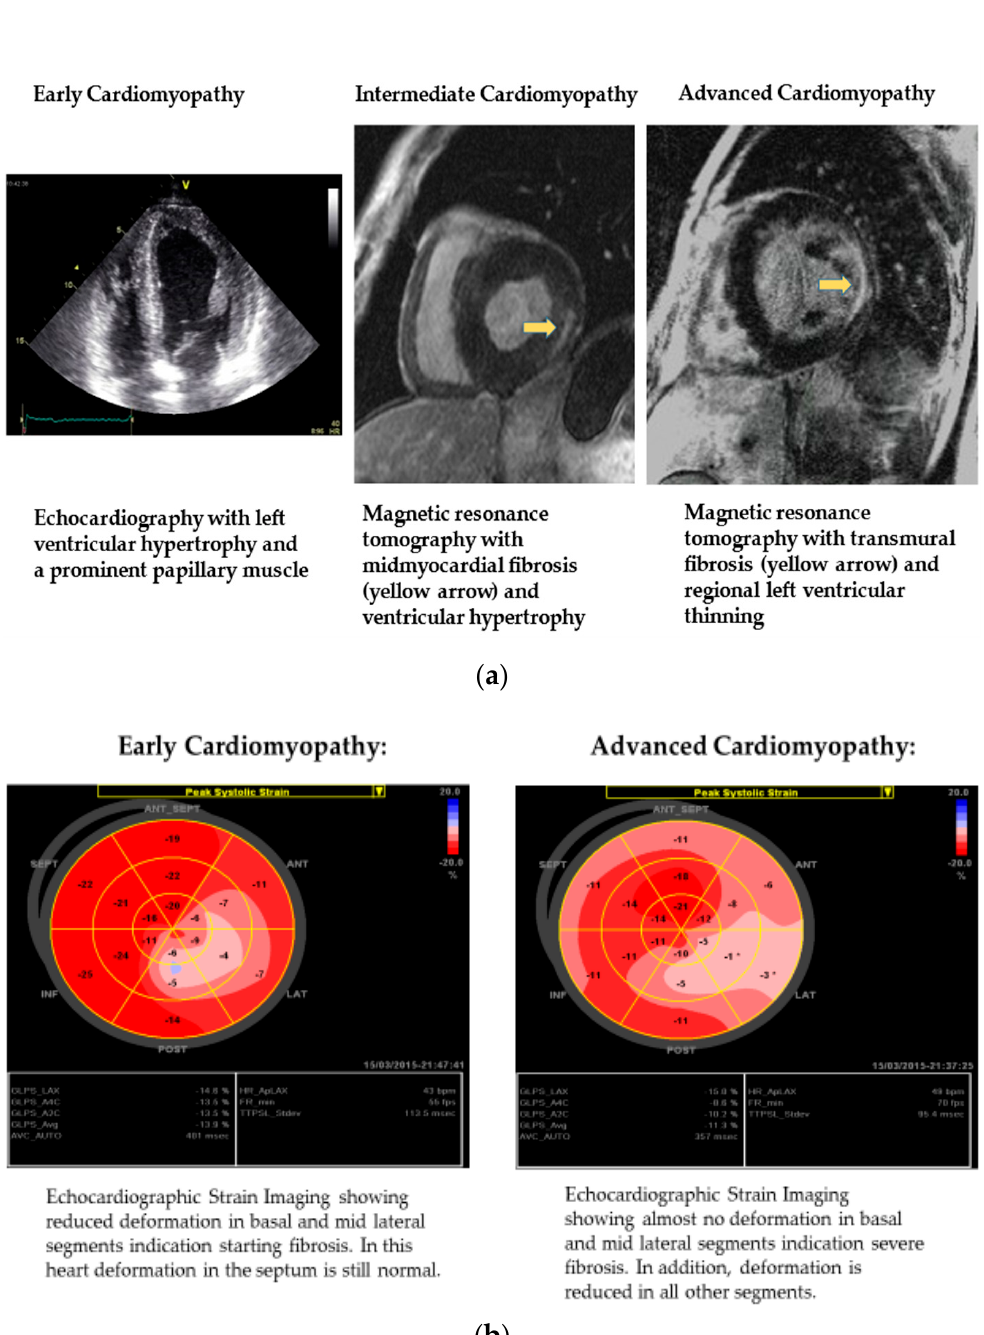
Figure 1. ( A ) Echocardiographic aspects and magnetic resonance tomography findings in various stages of Fabry cardiomyopathy. ( B ) Strain analysis in various stages of Fabry cardiomyopathy.